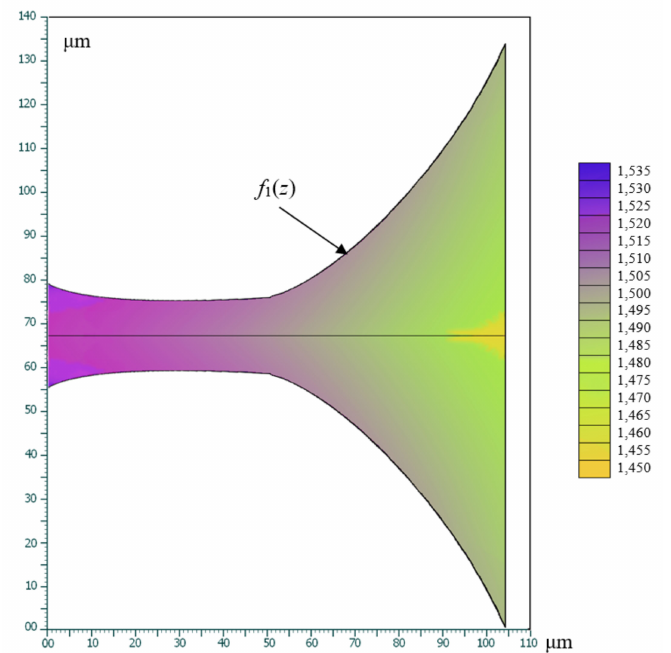
Figure 4. An illustration of the calculated parameters (distribution of the refractive index gradient defined by f 1 ( z )) at the second iteration of the calculation under the condition that the power of the generated wave P 3 is at least 1% of P 1 (see an explanation